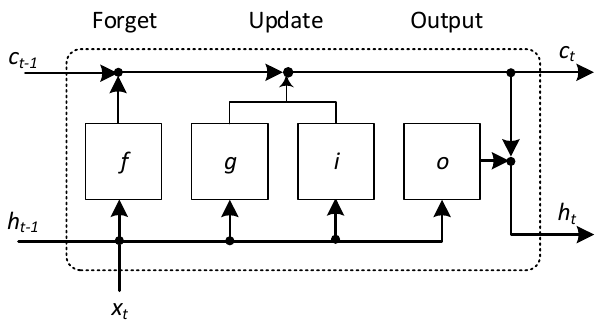
Figure 14. Structure of a long short-term memory (LSTM) layer [26].